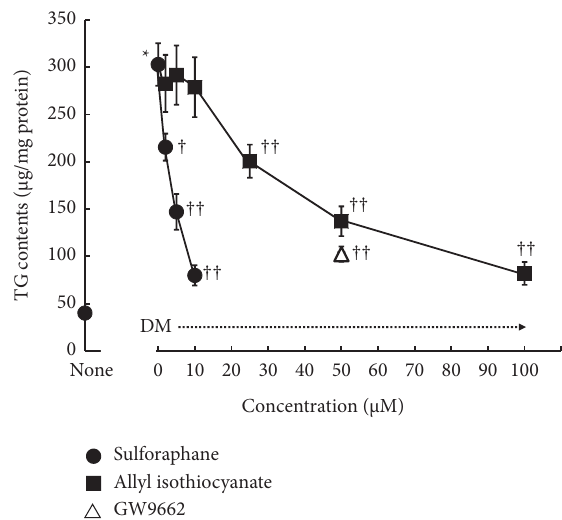
Figure 2: Alteration in triacylglycerol (TG) levels in 3T3-L1 ad- ipocytes treated with sulforaphane or allyl isothiocyanate. Data are presented as the mean ± standard error ( n � 4 − 16). ∗ denotes P < 0 . 01, versus untreated cells (none); † denotes P < 0 . 05; †† denotes P < 0 . 01, versus cells cultured in differentiation